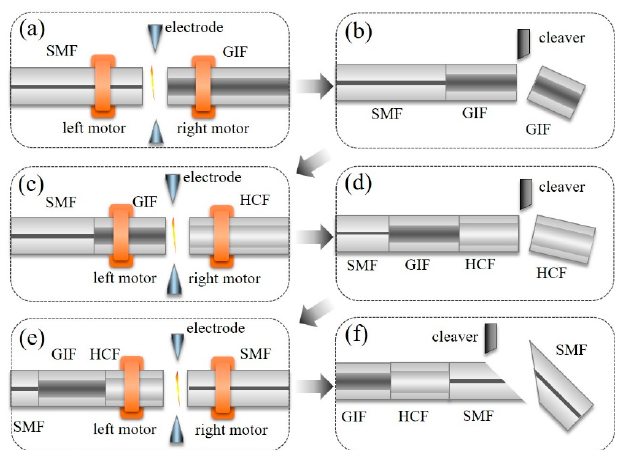
Figure 3. The fabrication process for the vibration sensor based on an FPI with an in-fiber collimator. ( a ) Step 1: splicing a segment of GIF to the SMF; ( b ) Step 2: cleaving the GIF with remaining length of 200 µ m; ( c ) Step 3: splicing a segment of HCF to the end of GIF; ( d ) Step 4: cleaving the HCF with